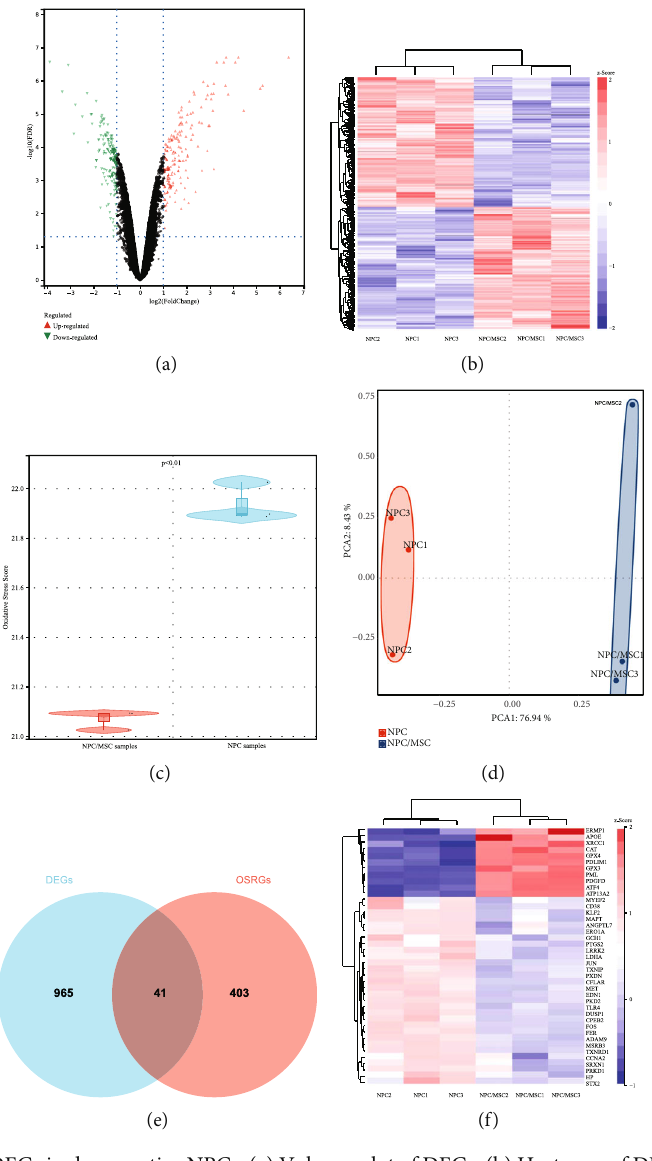
Figure 2: Determination of OSRDEGs in degenerative NPCs. (a) Volcano plot of DEGs; (b) Heat map of DEGs; (c) Comparison of oxidative stress score between NPC/MSC samples and NPC samples; (d) Principal component analysis of OSRGs; (e) Venn diagram to obtain the OSRDEGs; (f) Heat map of